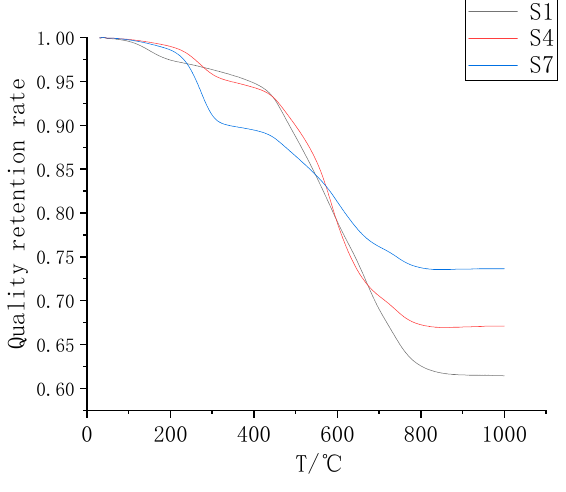
Figure 7. S1, S4, and S7 TGA diagrams.